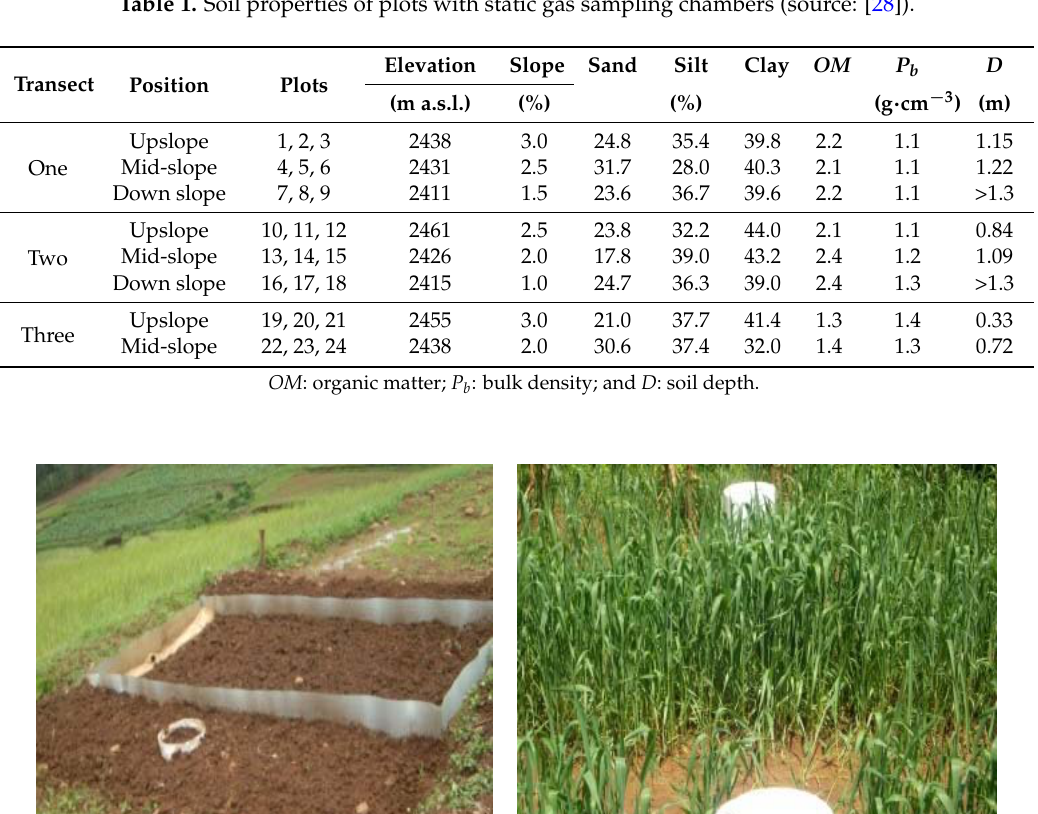
Table 1. Soil properties of plots with static gas sampling chambers (source: [28]).